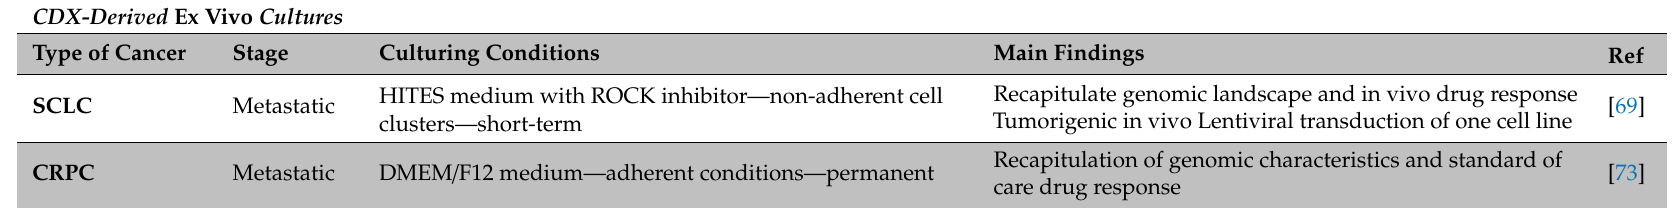
Table 2. Overview of CDX-derived ex vivo cultures established to